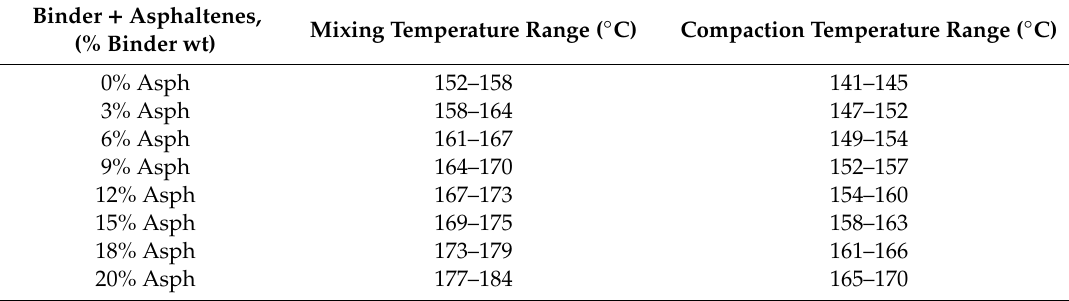
Table 3. Mixing and compaction temperature range of base and asphaltenes-modified binders.